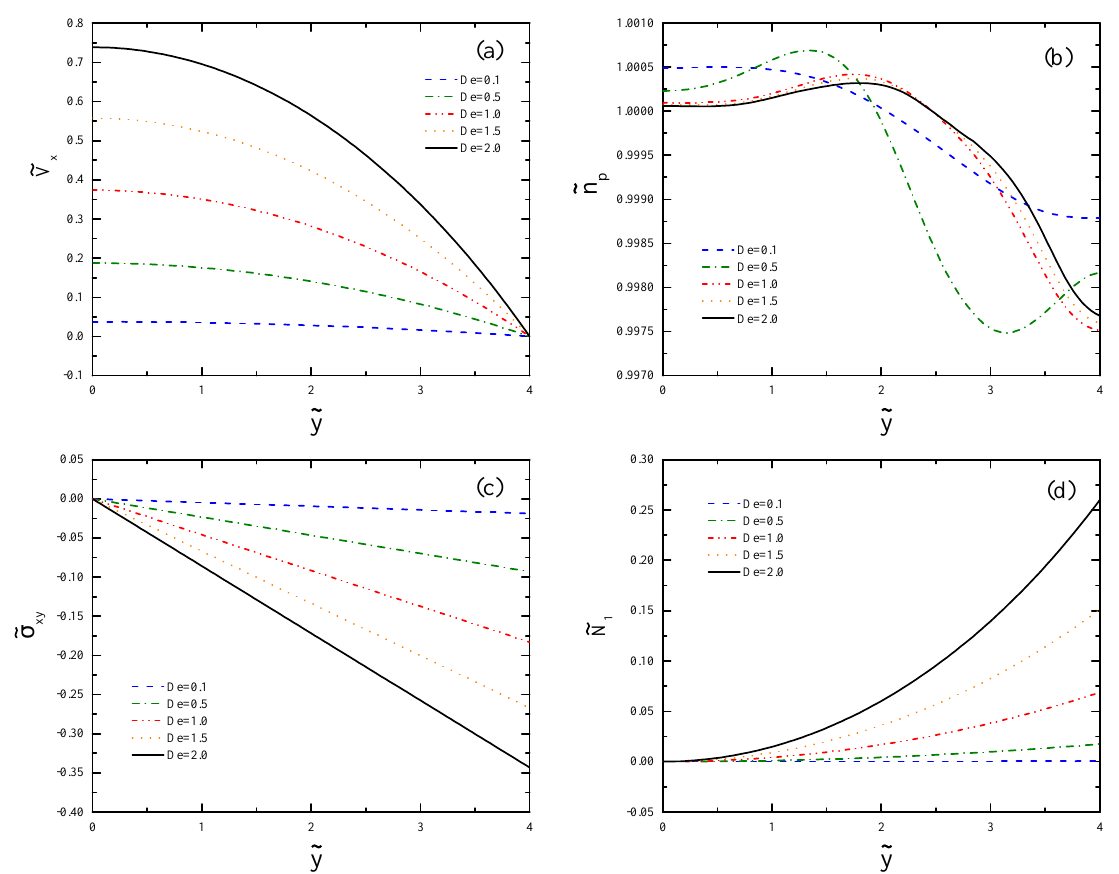
Figure 5. Profiles of ( a ) axial velocity, ( b ) polymer number density, ( c ) shear stress, and ( d ) first normal stress difference evaluated at ˜ x = − 75 for different Deborah